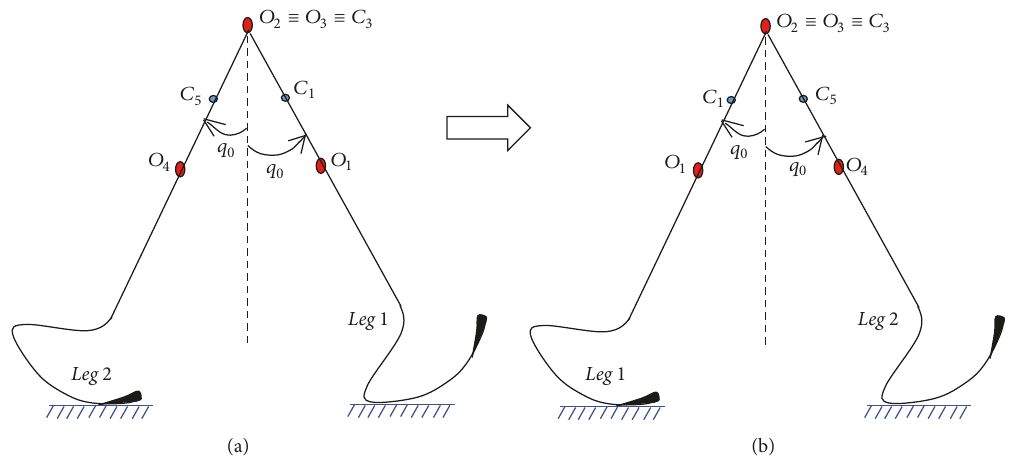
Figure 8: Position of two legs. (a) Before the step and (b) after the